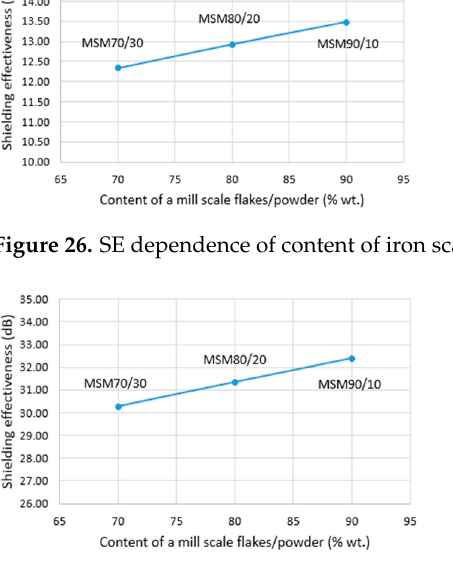
Figure 27. SE dependence of content of iron scale mix of flakes and powder. Frequency—23 GHz.